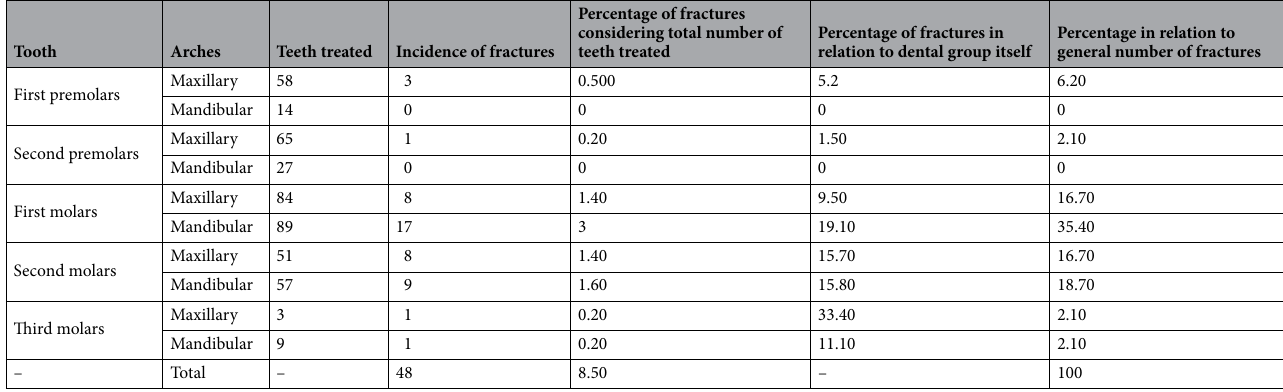
Table 4. Number and percentage of teeth in which fractures occurred.